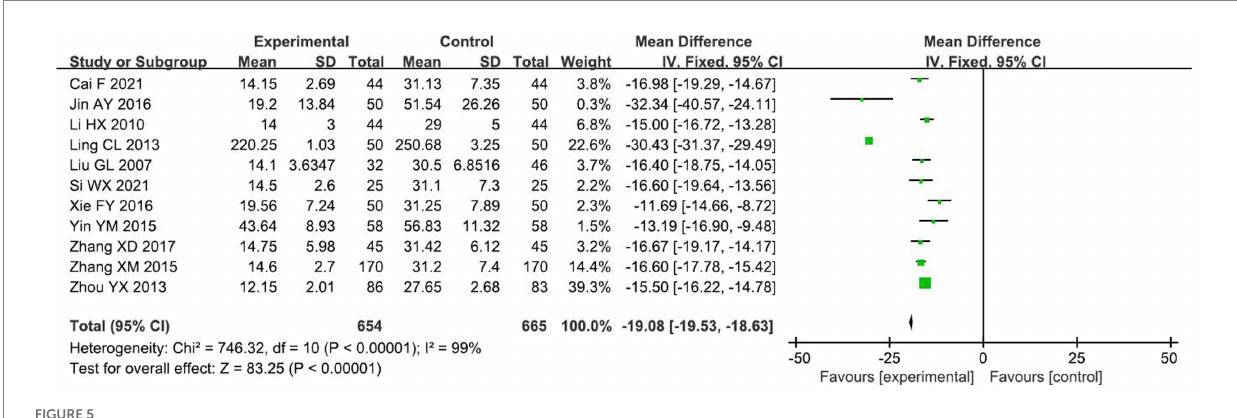
FIGURE 5 Comparison of incisional bleeding between the two groups.